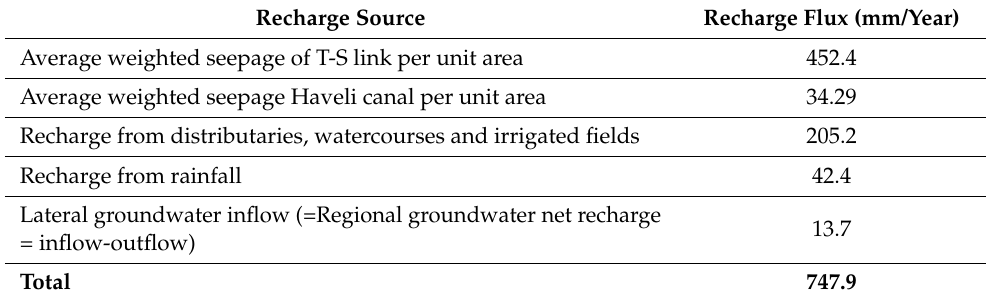
Table 1. Recharge Flux to Groundwater Aquifer (Source: [19]). Recharge